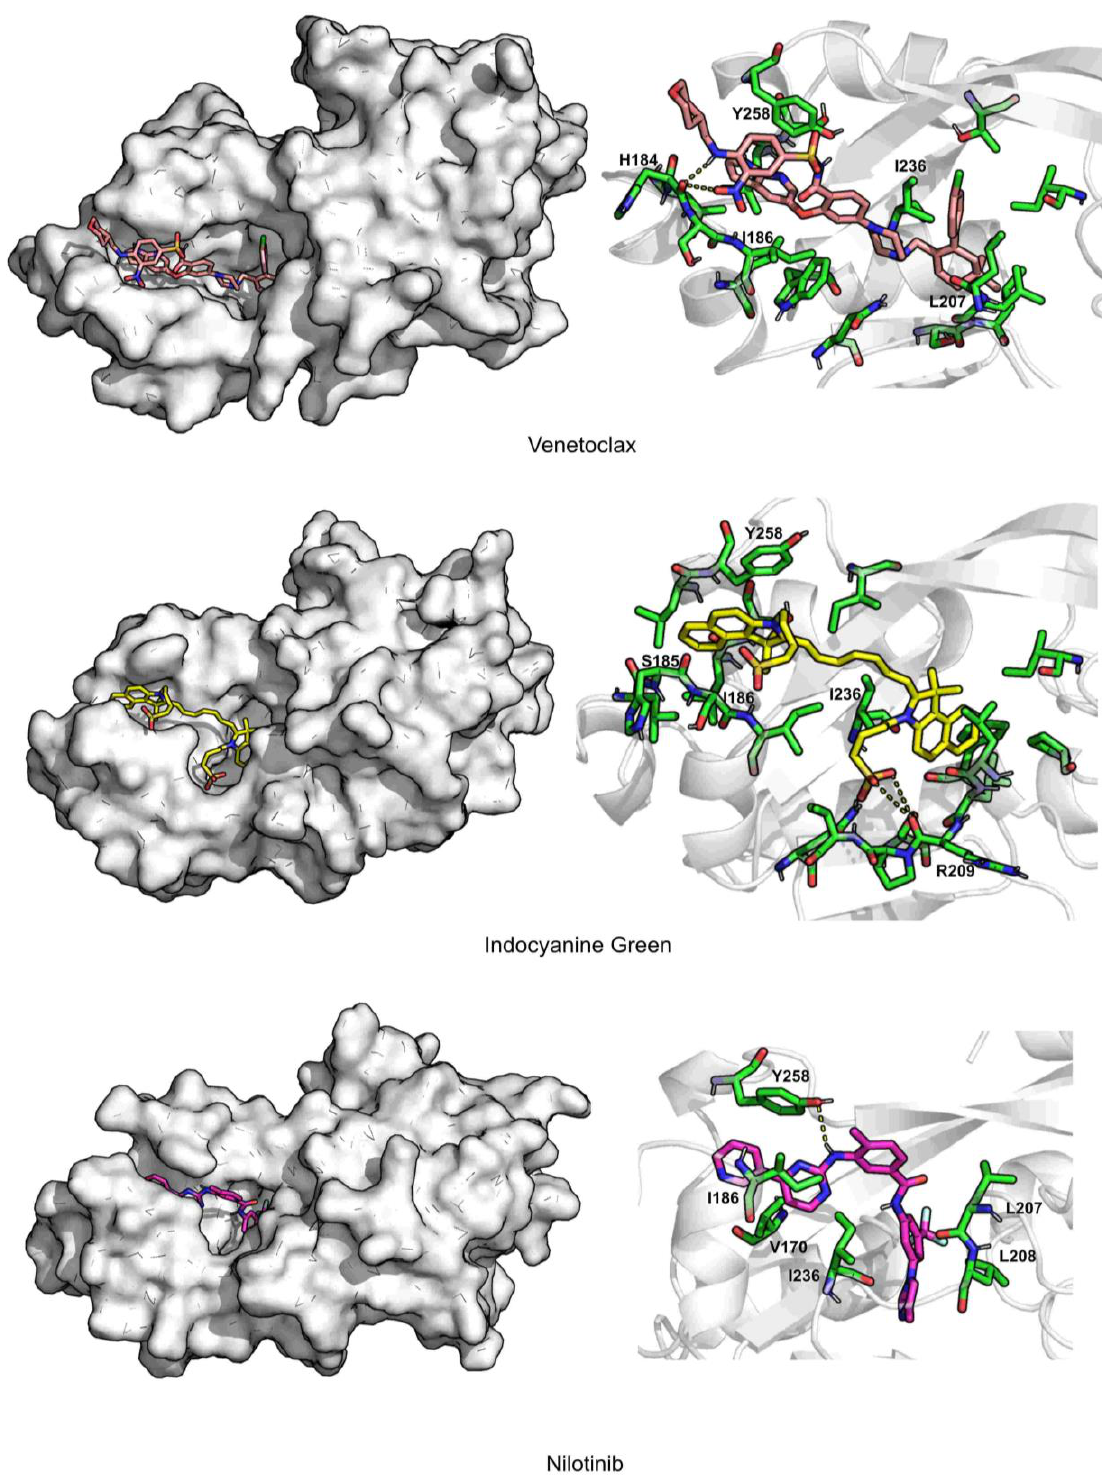
Figure 7. Interaction maps for venetoclax, indocyanine green, and nilotinib.